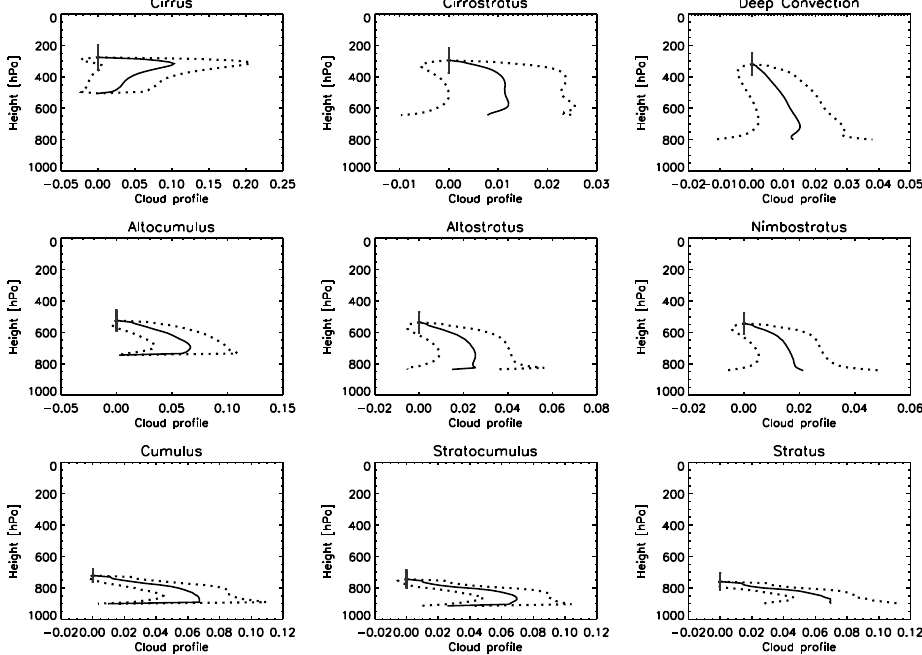
Figure 1. Normalized mean cloud vertical extinction profiles (solid line) for nine cloud types based on the ISCCP cloud classification. The standard deviation of extinction is shown by the dotted line, and the standard deviation of the cloud top pressure is shown by the error